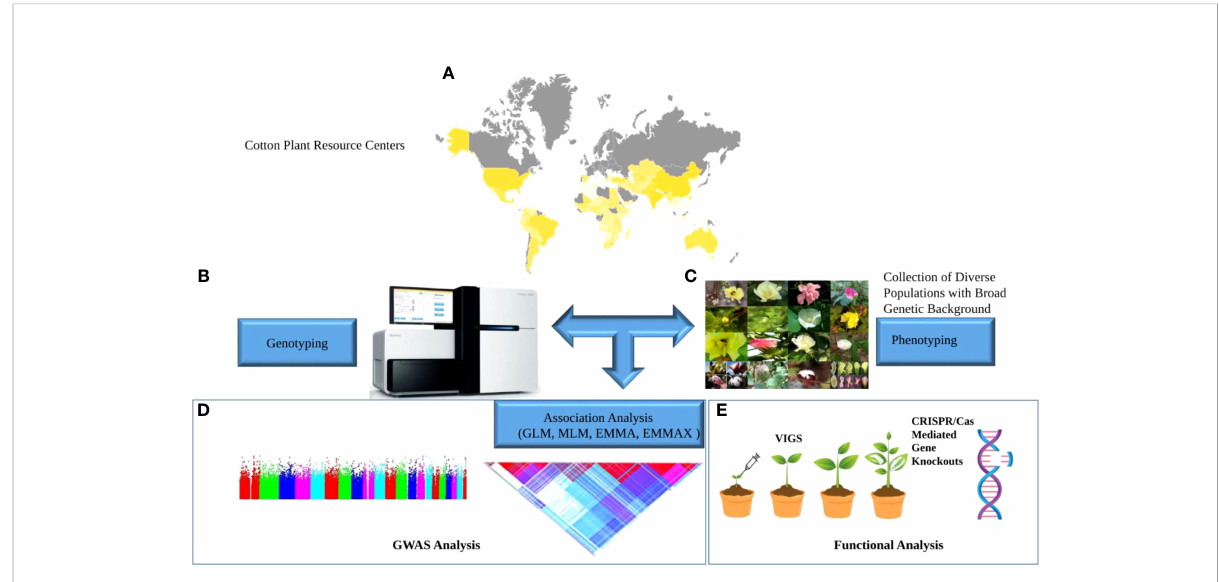
FIGURE 1 Schematic fl ow of GWAS. Collection of diverse germplasm; (A) Yellow shaded area on the world map depicts key cotton-growing countries; (B) Genotyping platform (C) Phenotypic diversity in cotton crop (D) GWAS analysis to fi nd associated SNPs. (E) Functional validation of genes associated with traits under